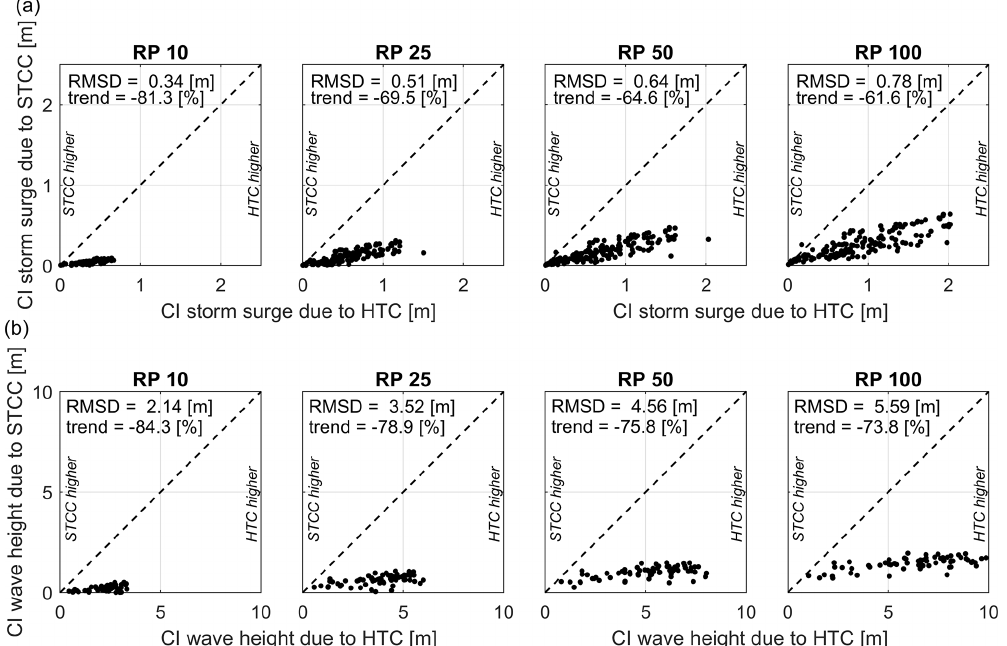
Figure 9. Scatterplots of 95% confidence intervals (97.5th minus 2.5th percentile) for storm surge (a) and wave heights (b) , both resulting from HTCs ( x axis) and STCC ( y axis), for return periods of 10, 25, 50 and 100 years, for all locations along the Bay of Bengal. Root-mean- square differences (RMSDs) and the trend (%) of STCC compared to HTCs are also